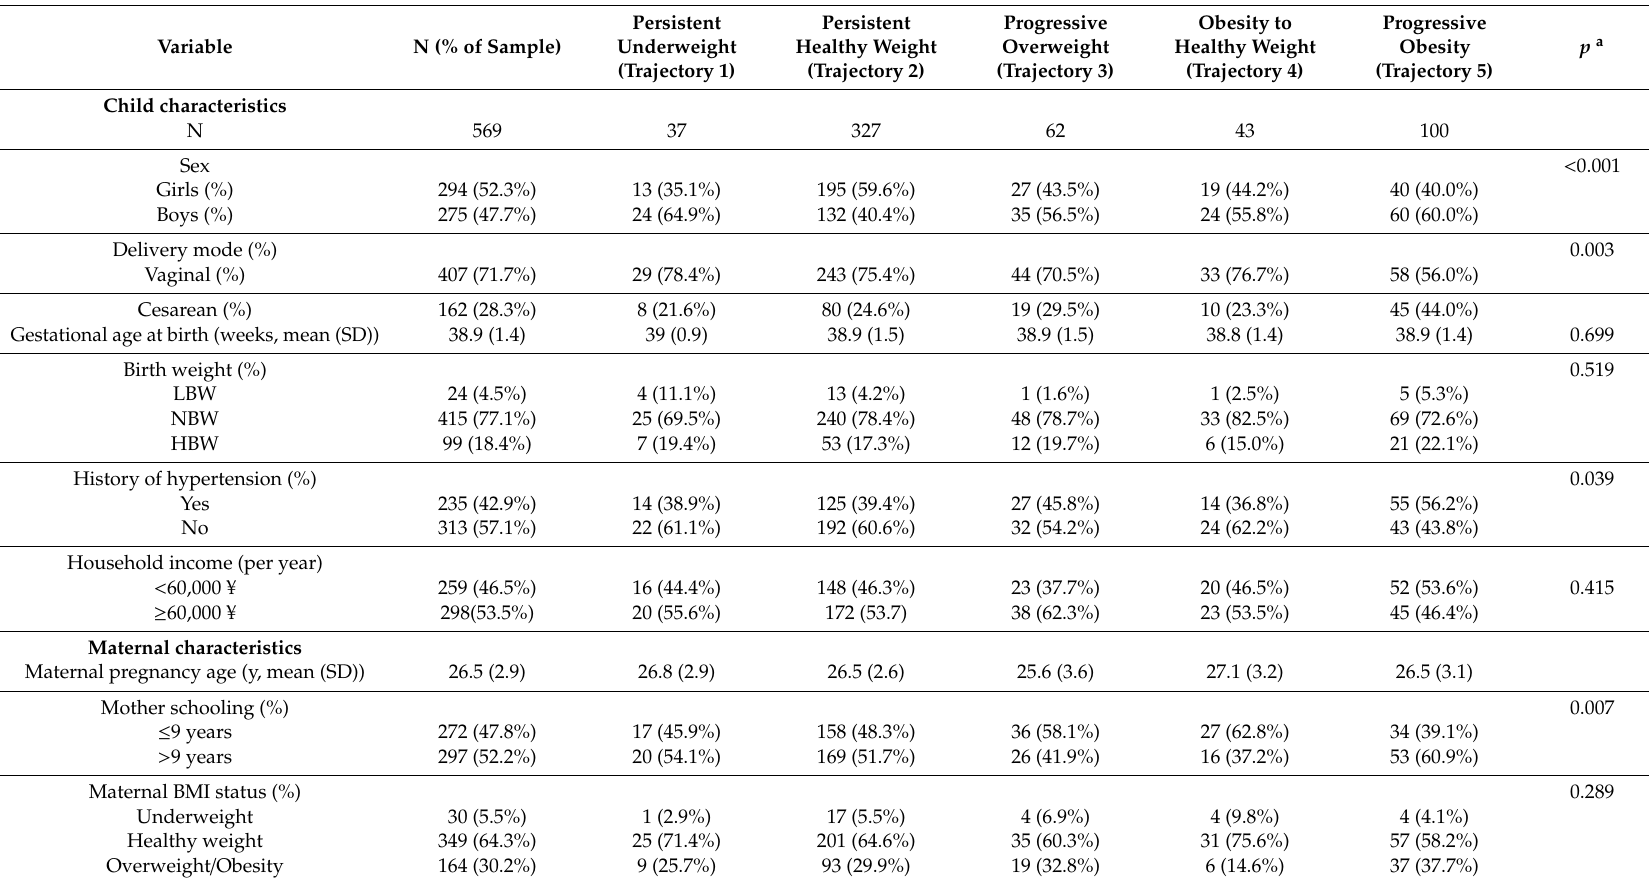
Table 1. Participant characteristics for each of the five di ff erent body mass index trajectory